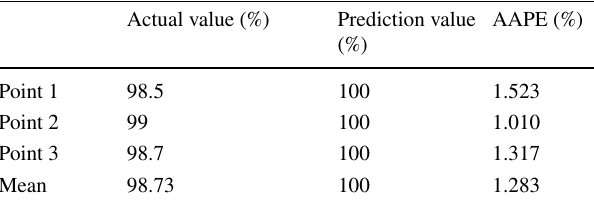
Table 4 The actual, the predicted, and the AAPE values of the con- firmatory